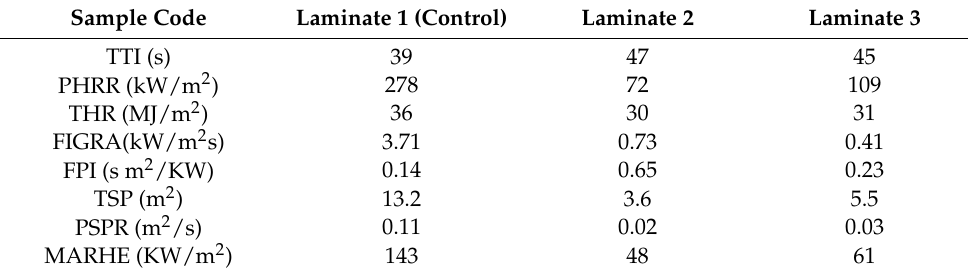
Table 4. Cone calorimeter data of different